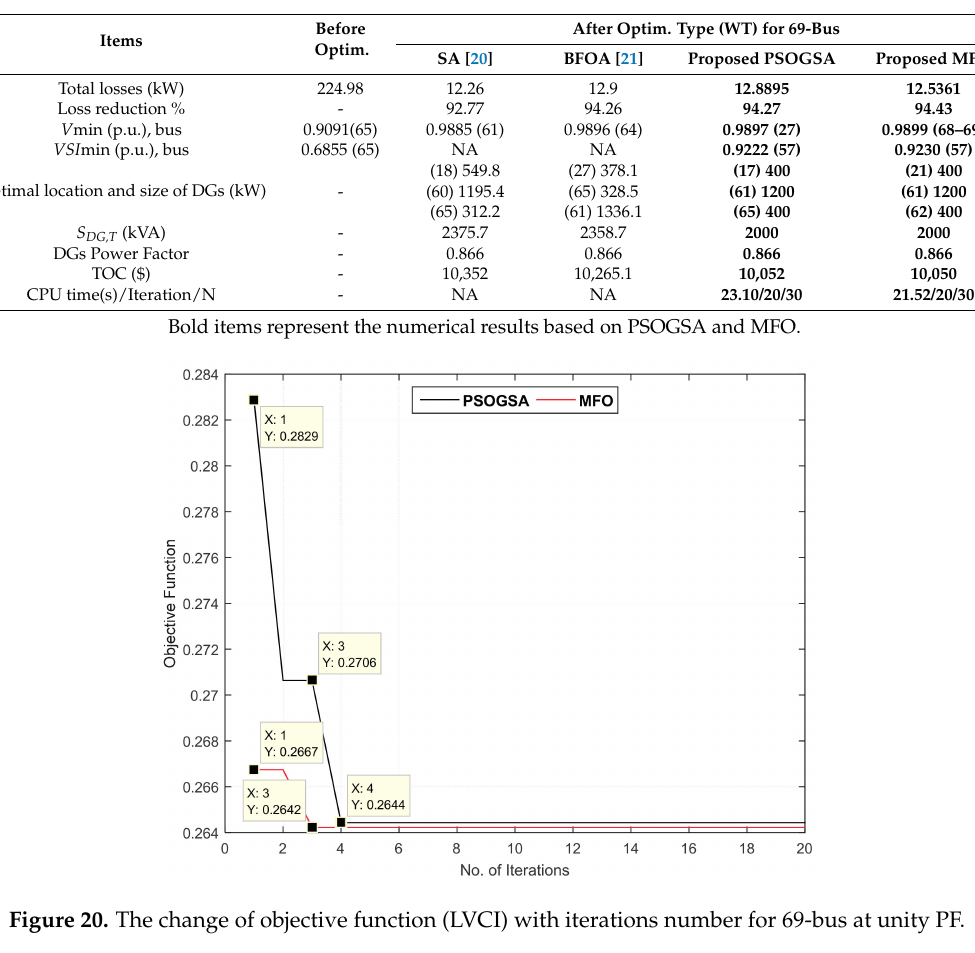
Table 7. The results of 69-bus IEEE distribution network at 0.866 PF (WT type).